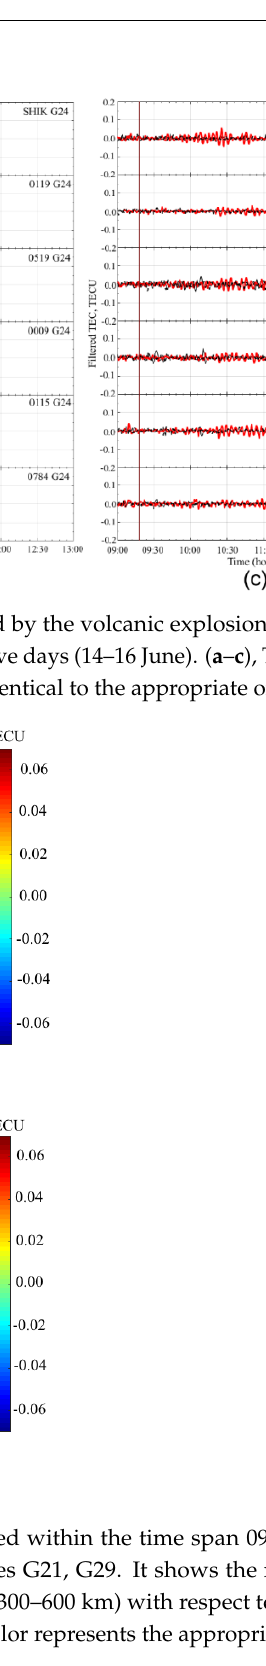
Figure 12. The traveltime diagram plotted within the time span 09:00 − 11:00 UT on 15 June 2009 by using ( a ) satellite G24 and ( b ) satellites G21, G29. It shows the most prominent CVIDs in the near-field (0 – 200km) and far-field zone (300 – 600km) with respect to the volcano. The vertical red solid line indicates the explosion time. Color represents the appropriate TEC amplitude.